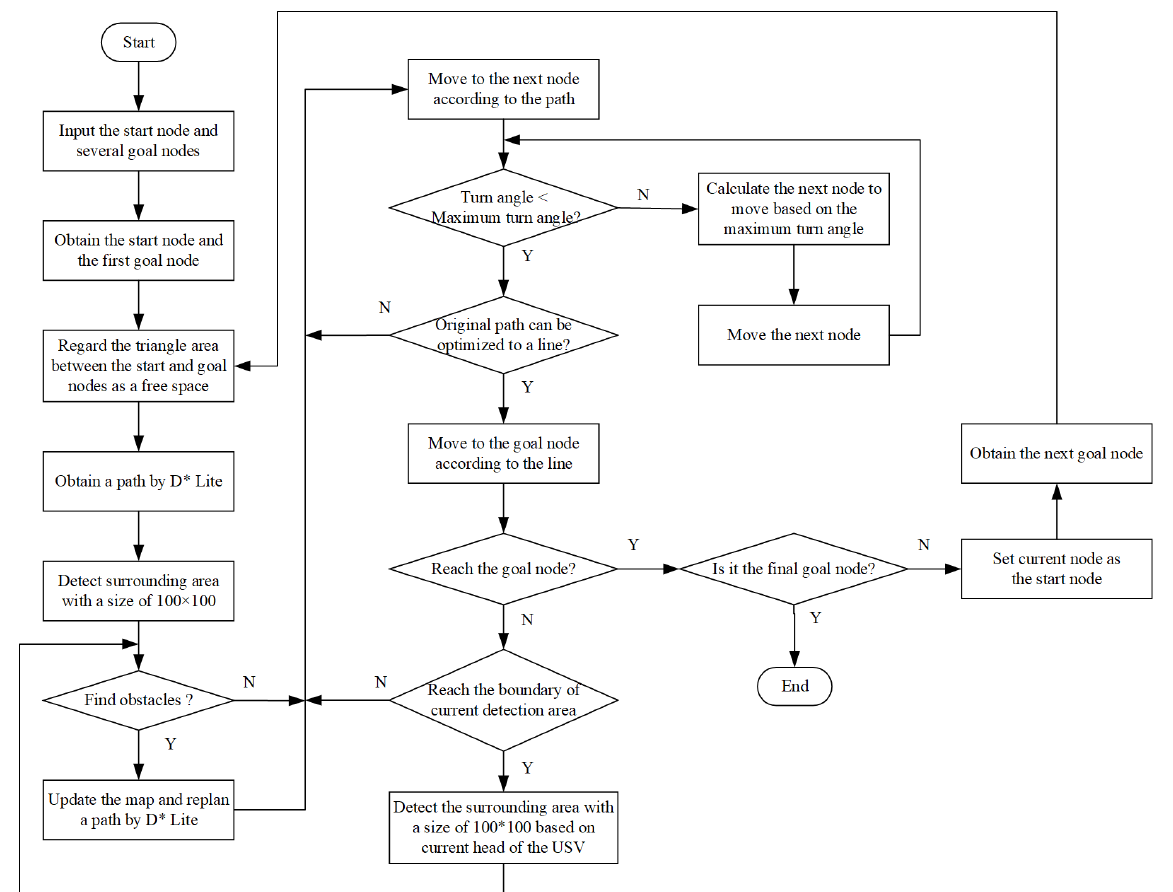
Figure 7. Procedure of multi-goal path planning in unknown environments.